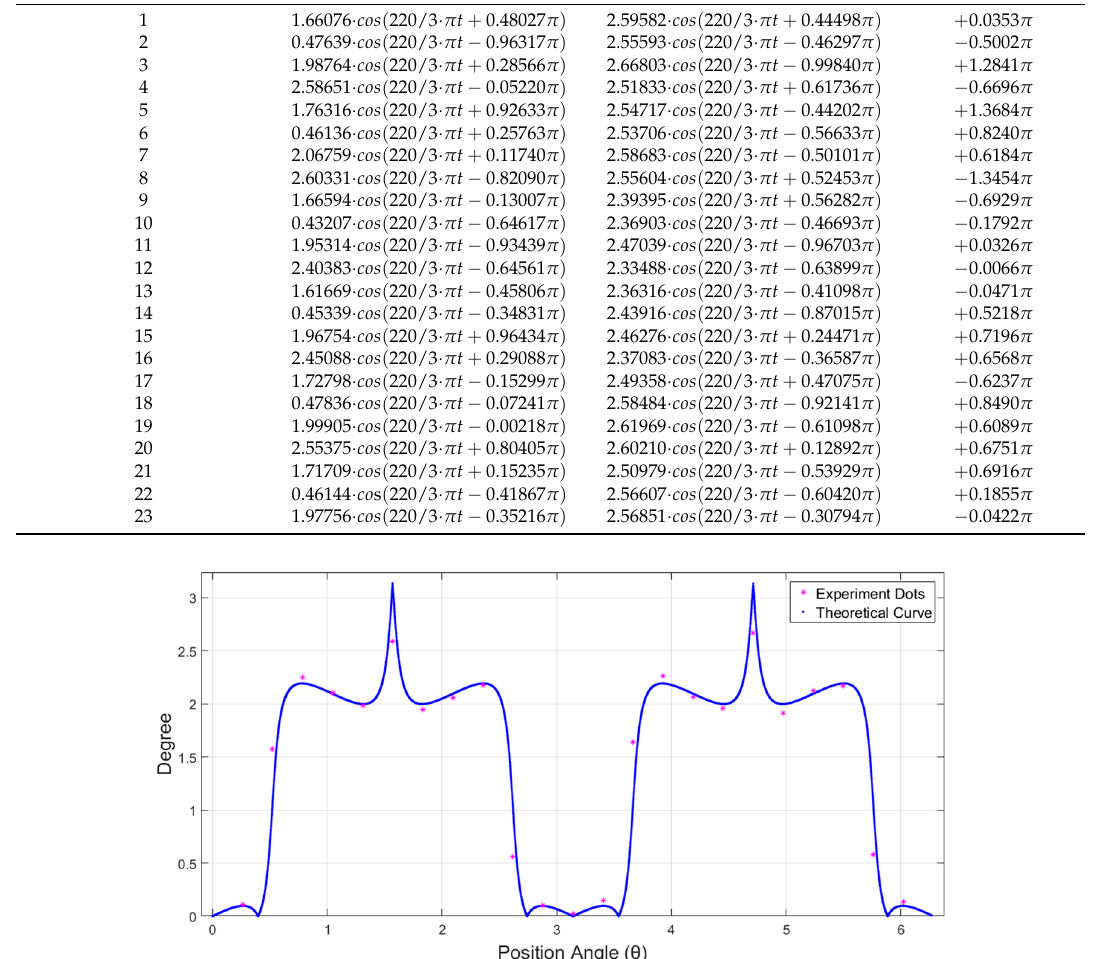
Figure 9. Comparison of experimental and simulation result of angle–position relation.